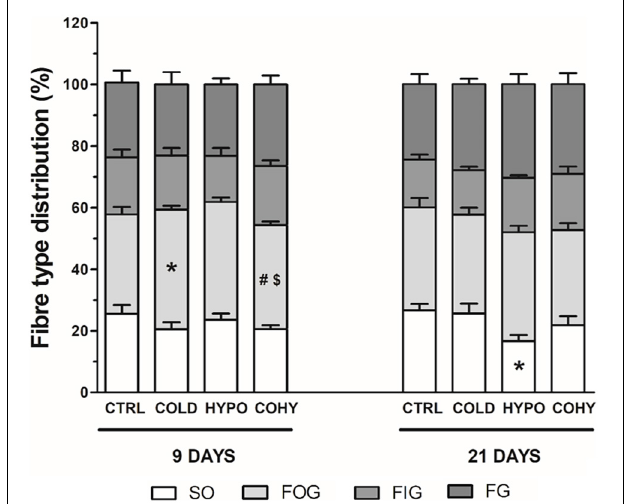
FIGURE 7 | Gastrocnemius fiber type distribution after 9 and 21 days. SO, slow oxidative; FOG, fast oxidative glycolytic; FIG, fast intermediate glycolytic; and FG, fast glycolytic. CTRL, control; COLD, intermittent cold; HYPO, intermittent hypoxia; COHY, intermittent cold + hypoxia. Data are presented as mean ± standard error. * p < 0.05 vs. CTRL, # p < 0.05 vs. COLD, $ p < 0.05 vs. HYPO. Sample size: n = 6 per group at each temporal time